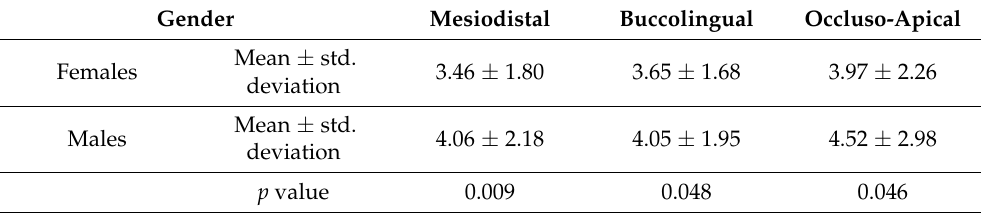
Table 2. Comparison of the mean ( ± standard deviation) dimensions of lesions in males and females.